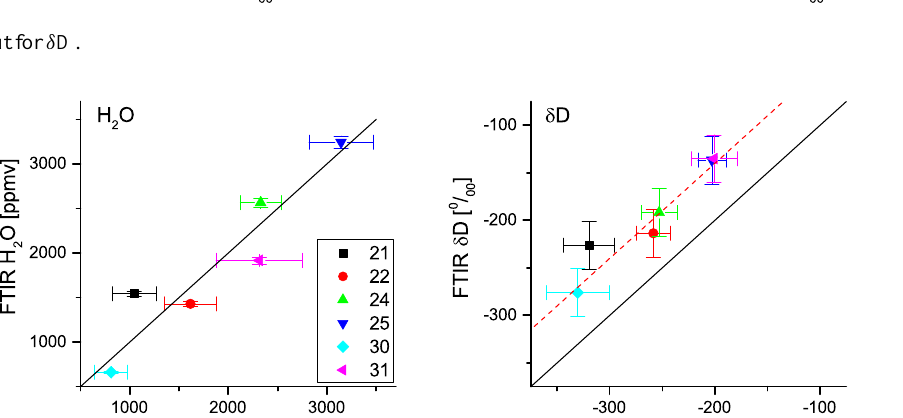
Figure 9. As Fig. 7, but for δ D.